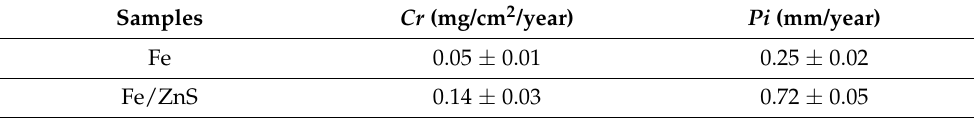
Figure 3. ( a ) The surface topography after removing corrosion products for Fe and Fe/ZnS composite, ( b ) AFM images and ( c ) the surface roughness profiles. The corrosion pits were marked by the red arrows. Table 2. The corrosion rates calculated from immersion and electrochemical tests.